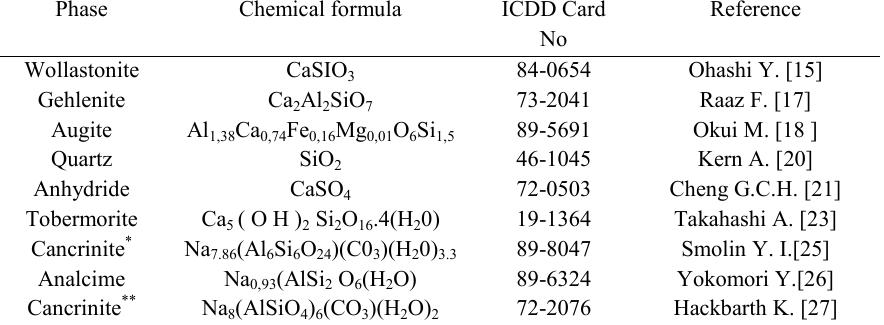
Table 4. Identified minerals in Timahdet OSA and MOSA and in the reactions product.